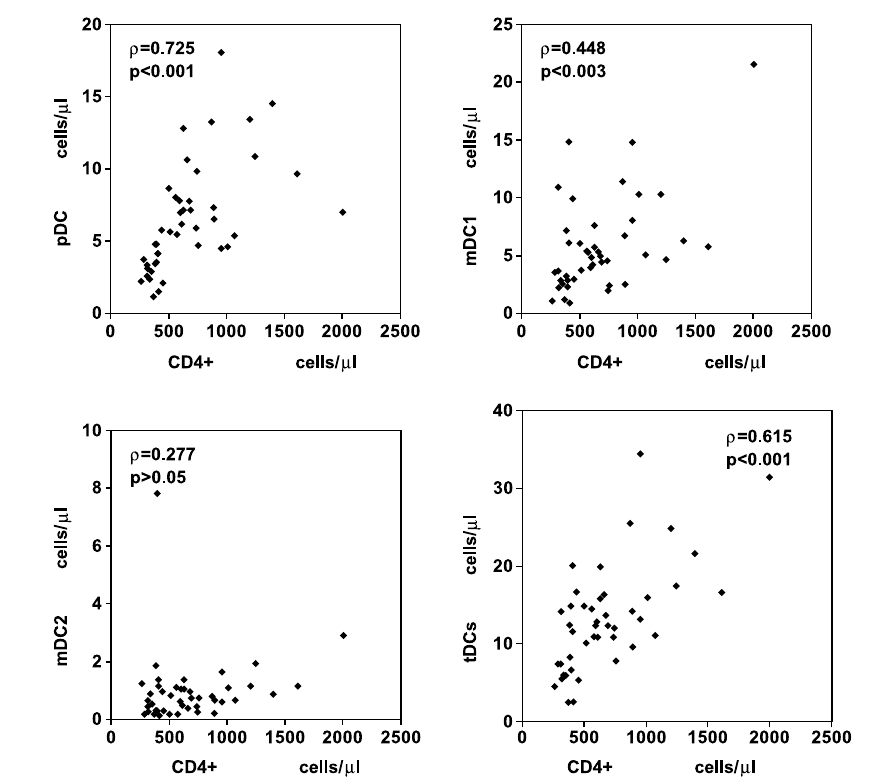
FIG. 2. Correlations between the number of T CD4 (cid:2) cells and total dendritic cells (tDC) and their pDC and myeloid (mDC1 and mDC2) subpopulations in the peripheral blood of SLE